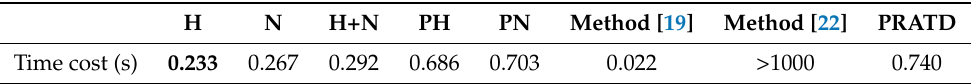
Table 9. Detection time of the different